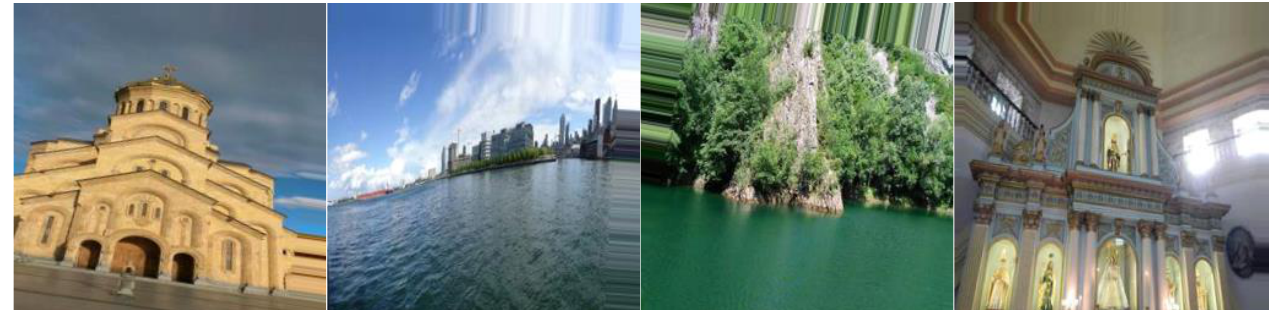
Figure 2. Landmark images from the Google Landmarks Dataset V2 [8].